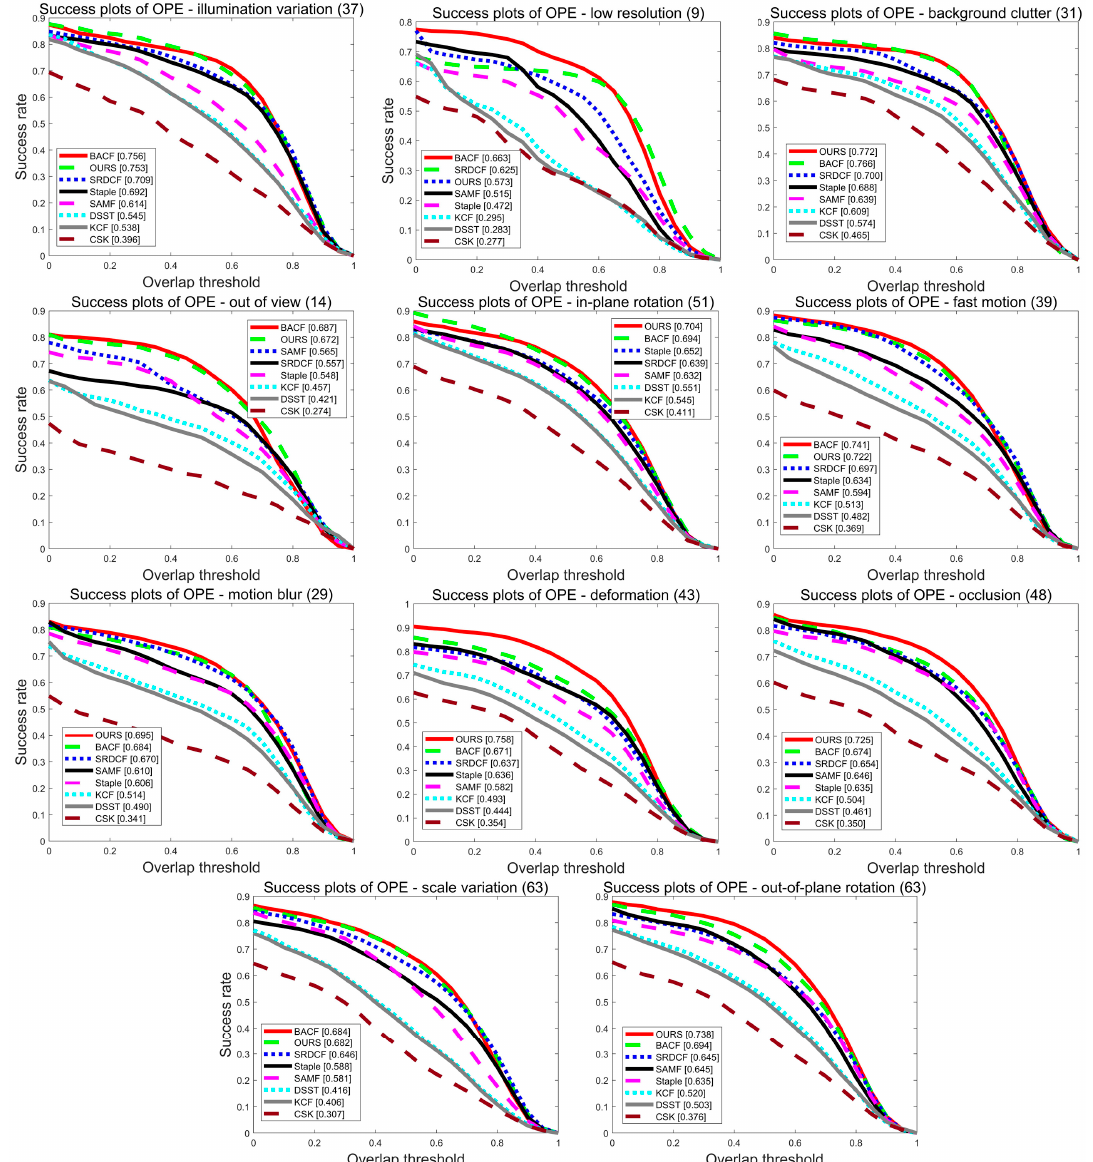
Figure 5. The success plot of eight algorithms for 11 challenge scenarios on the OTB-2015 dataset.